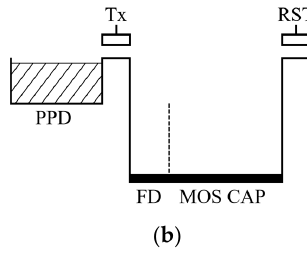
Figure 2. Proposed pixel for multiple charge transfer technique: ( a ) Schematic of the pixel; ( b ) Simplified pixel